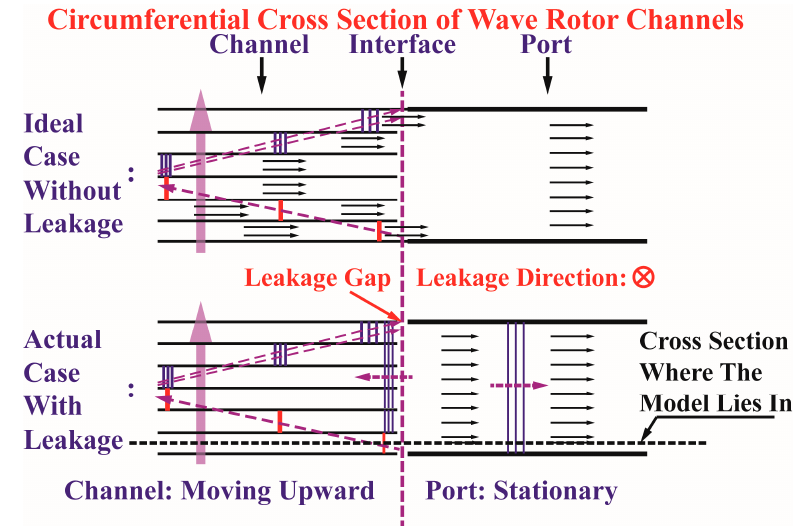
Figure 4. Selection of the analytical model for the study of reflected shock wave attenuation in wave rotors.